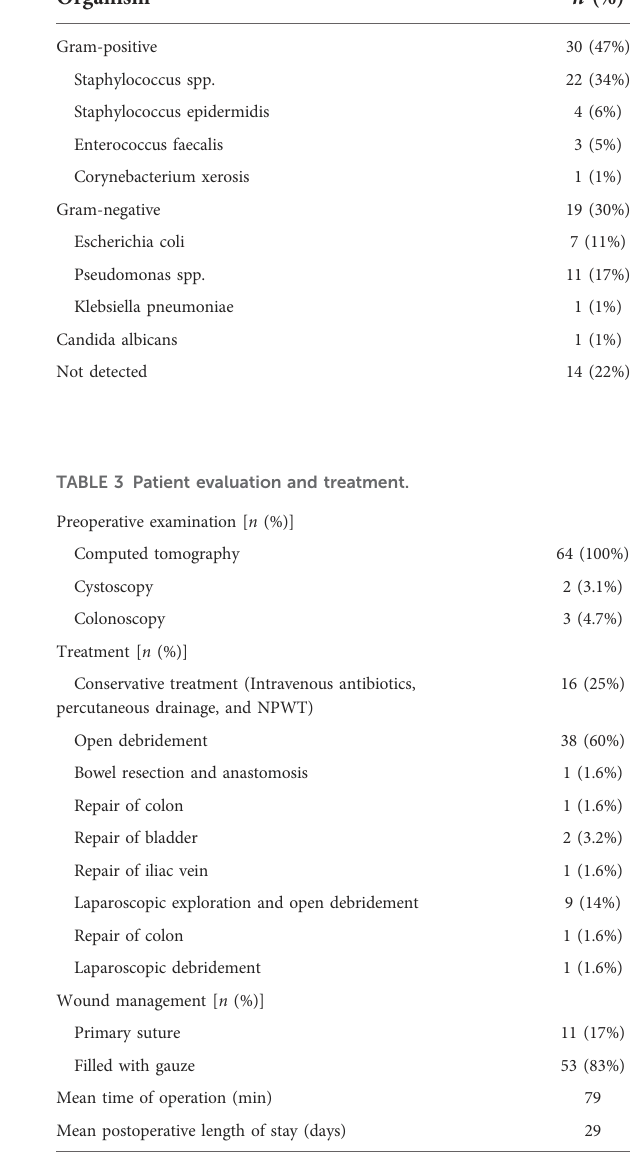
TABLE 1 Baseline patient characteristics. TABLE 2 Patient bacteriological culture results.